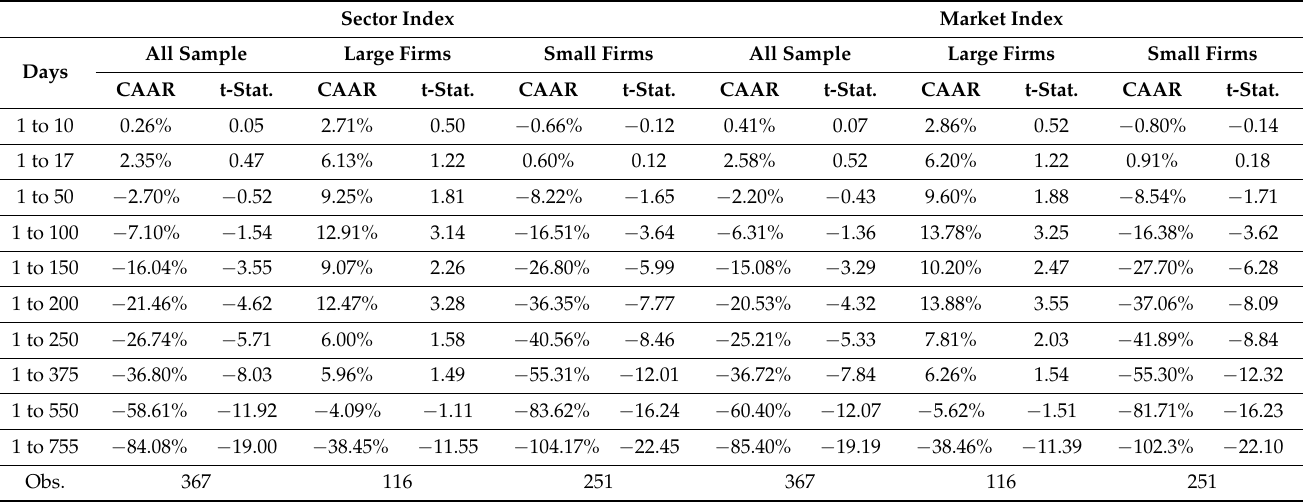
Table 3. Post-IPO CAARs, +1 to +755